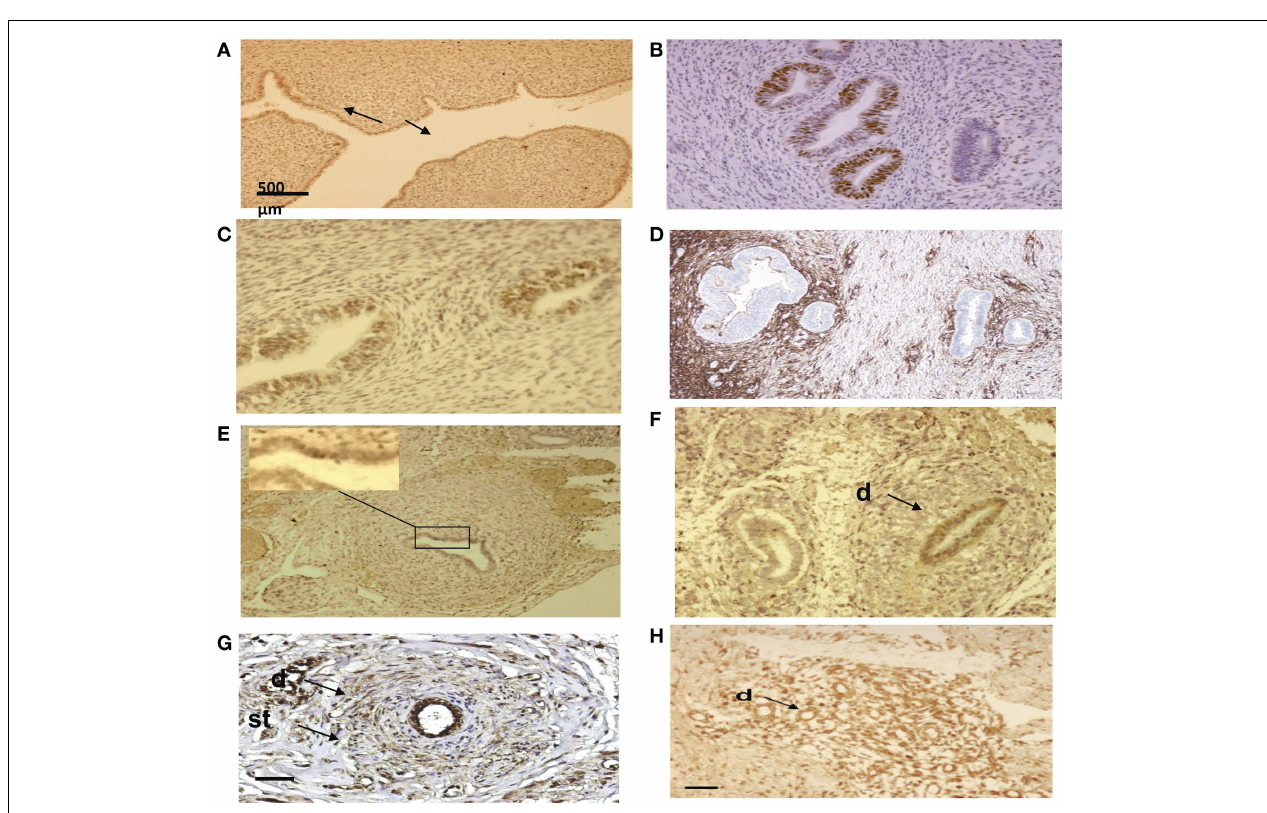
Expression of the PR in embryonic duct located in the ovarian ligament; insert at higher magnification (E) , expression of ER- α in a duct located under the fallopian tube serosa (F) , and expression of alpha-1-foetoprotein (G) and CD10 molecules (H) . D = duct; St = stromal layer. Scale bars; 500 µ m in (A) and 100 µ m in (B–H) .